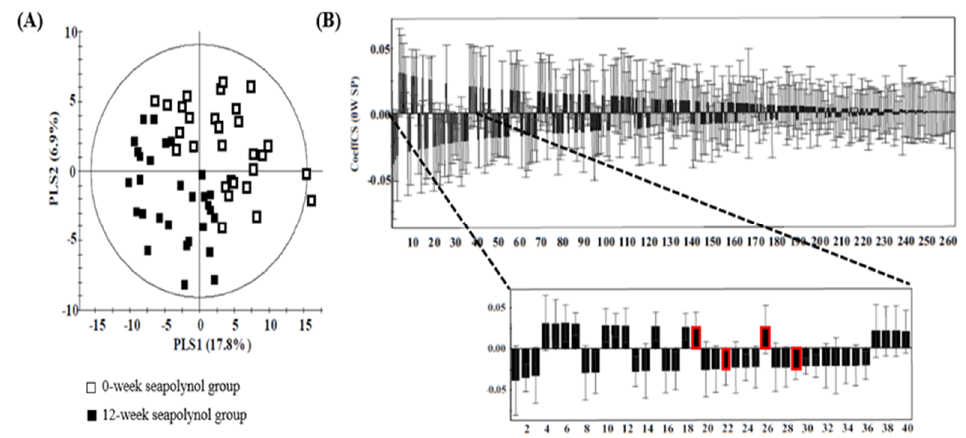
Figure 2. Partial least squares-discriminant analysis (PLS-DA) scatterplot of features that were significantly changed by seapolynol intake in the seapolynol group. ( A ) The PLS-DA scatter plot obtained from UPLC/QTOF MS spectra of human urine samples in positive ionization mode shows that the values at 0 weeks and at 12 weeks for the seapolynol grous are markedly separated (R2x = 0.247, R2y = 0.653, Q2 = 0.273). ( B ) Coefficient plot of the PLS-DA model. Features in the top 15% of the absolute values of the coefficient plot were selected to identify the metabolites significantly changed after seapolynol intake. The red boxes represent the coefficient plot value of the identified metabolites.